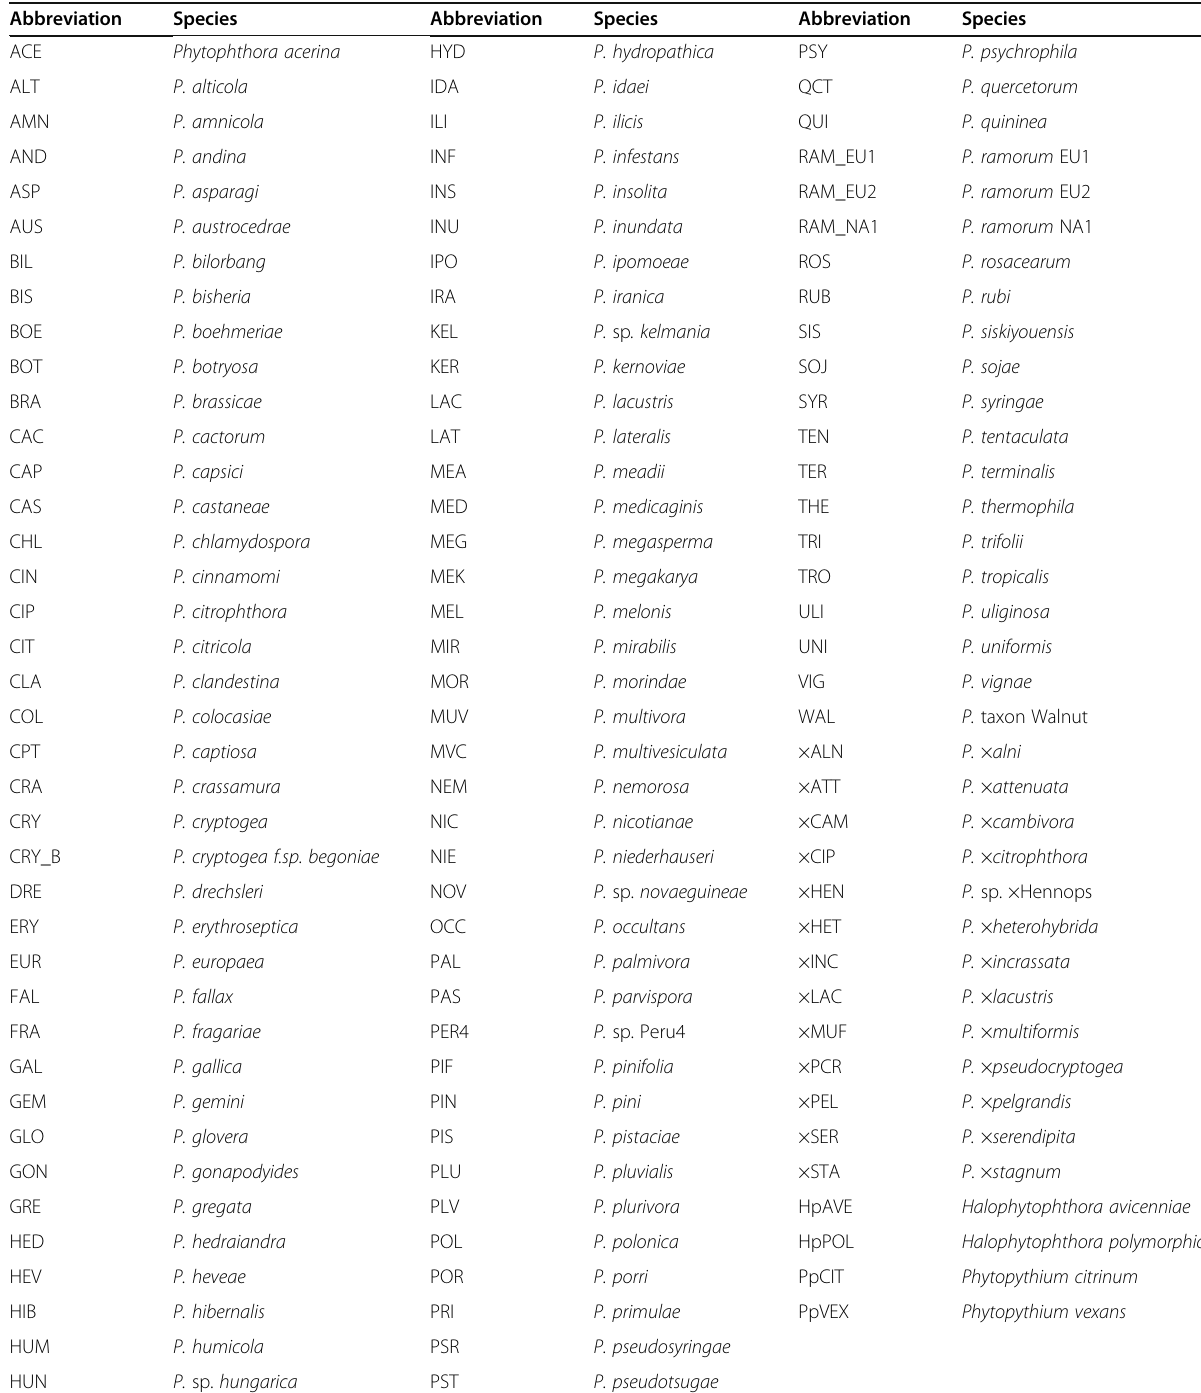
Table 1 Abbreviations of species names used in tables and